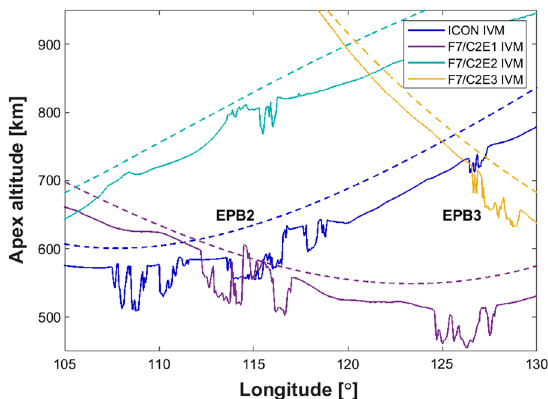
Fig. 8 The longitudinal variations of the apex height (solid lines) and ion density (dashed lines) mesured by the ICON, F7/C2E1, F7/C2E2, and